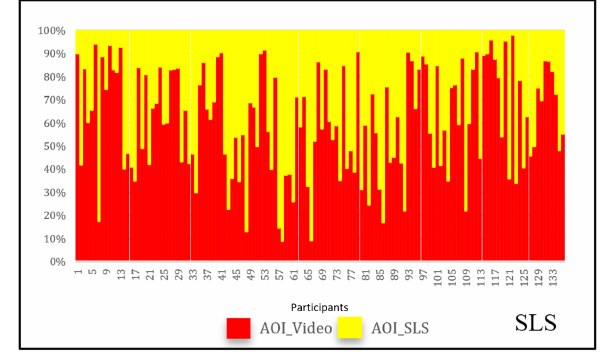
Figure 7: Percentage of fixations in video with SLS